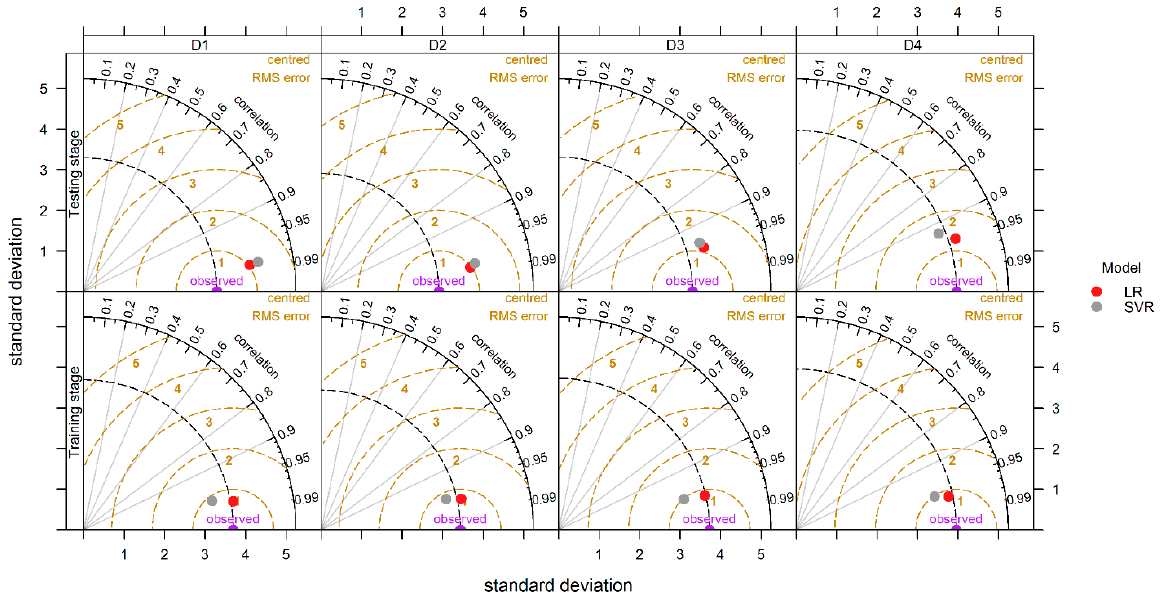
Figure 8. Taylor diagram of testing and training results of LR and SVR models with D1, D2, D3, and D4 datasets for weight prediction of strawberry fruits.